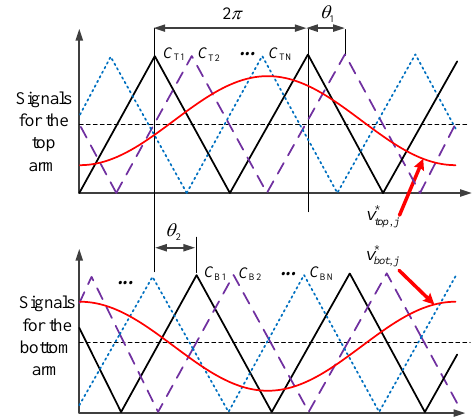
Figure 3. General MMC phase-shifted carrier sinusoidal pulse-width modulation (PSC-SPWM)